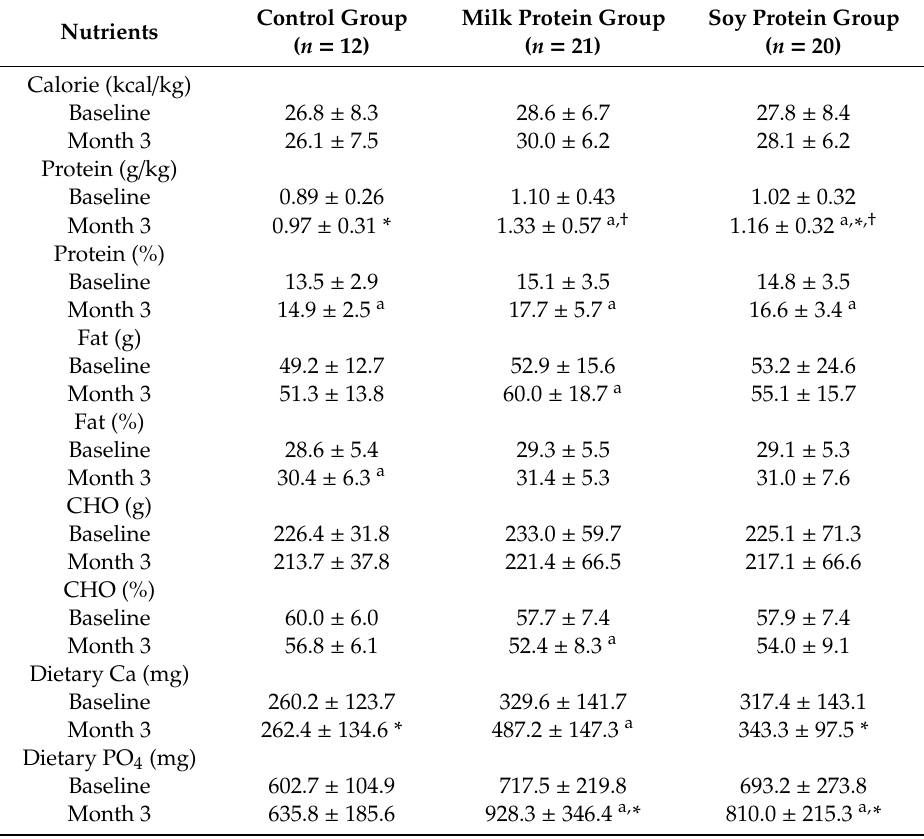
Table 3. Daily nutrients’ intake in di ff erent groups during intervention.